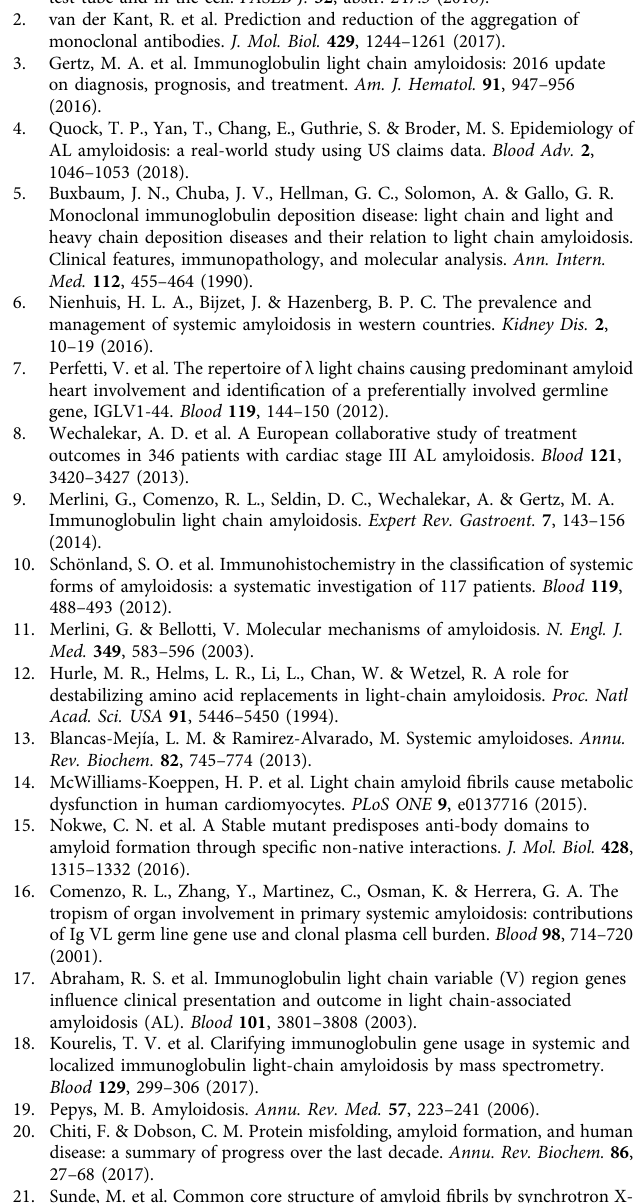
Table 3). WALTZ: values above 0.00 are considered as hits. TANGO: Beta sheet aggregation values above 0.00 are considered as hits. Fold amyloid: Amino acid residues having values above 21.4 for fi ve consecutive residues are considered as hits. Aggrescan: Amino acid residues having value greater than − 0.02 are con- sidered as hot spots. AmylPred: Sequence regions predicted as hits by the Con- sensus method. Protein structure representation . Representations of reconstructed densities and re fi ned models were created with UCSF Chimera 59 . A native LC structure was reproduced from protein data base (PDB) entry 1BJM 60 based on its sequential similarity to our fi bril protein and the presence of an IGLV1-44 germ line